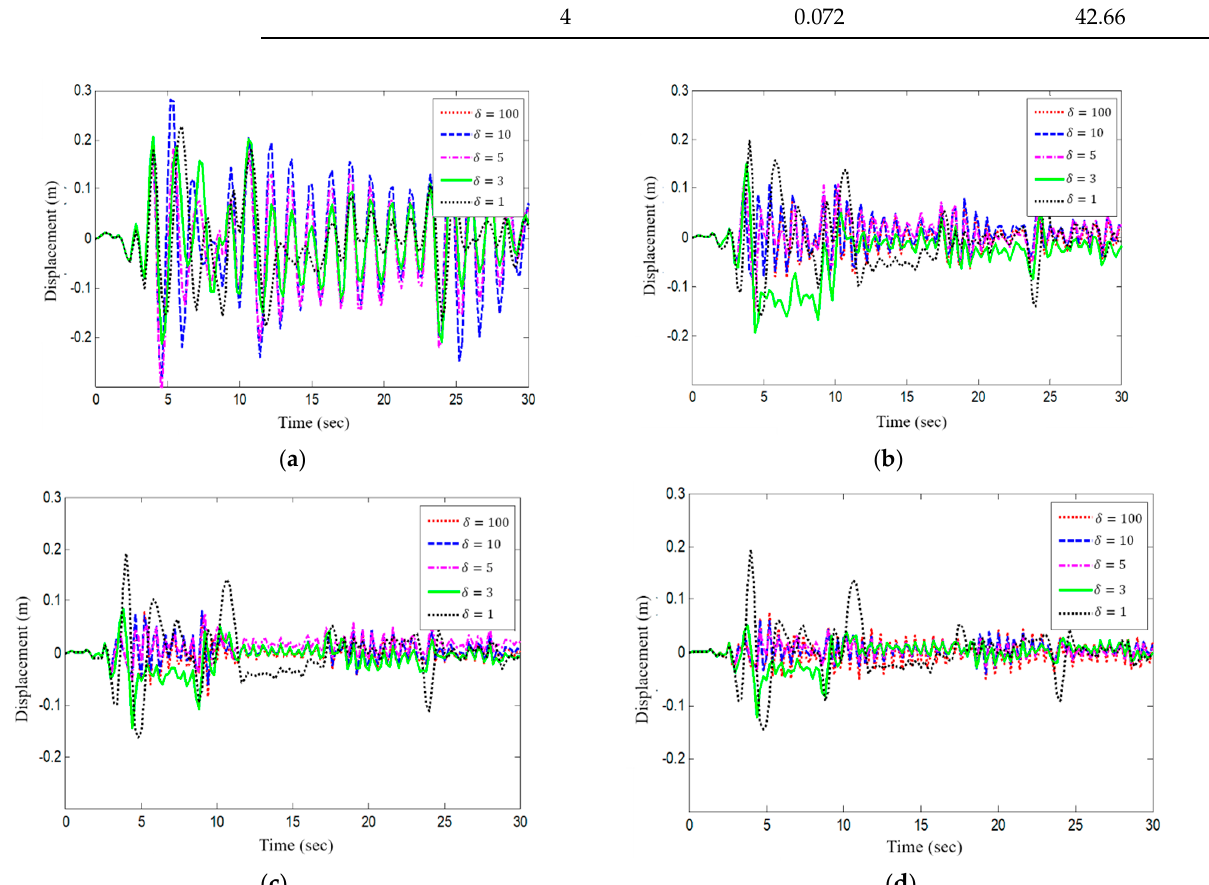
Figure 16. Displacement responses under different DOFs. ( a ) Displacement response of SDOF structure ( ξ = 0.05, T = 1.4 s). ( b ) Displacement response of 2DOF structure( ξ = 0.05, T = 0.81 s). ( c ) Displacement response of 3DOF structure ( ξ = 0.05, T = 0.64 s). ( d ) Displacement response of 4DOF structure ( ξ = 0.05, T = 0.56 s).